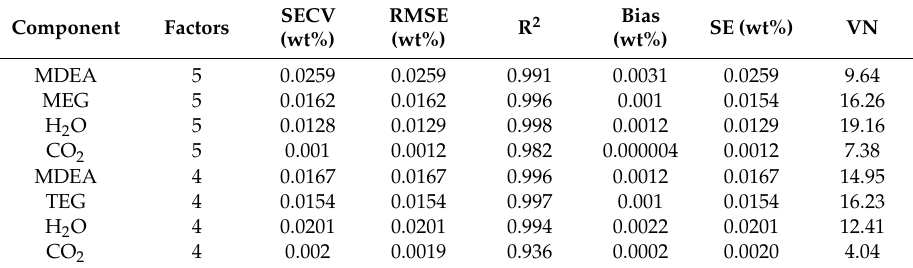
Figure 7. Actual vs. predicted values of four-component systems; the MDEA-MEG-H 2 O-CO 2 system ( a ) and MDEA-TEG-H 2 O-CO 2 system ( b ). Table 5. Summary of results for four-component